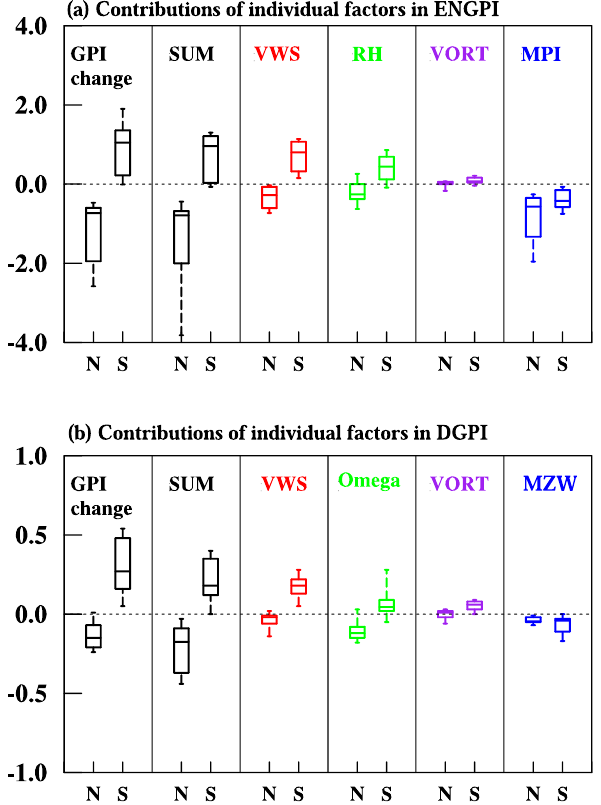
Fig. 2 Contributions of individual large-scale environmental factors to the tropical cyclone (TC) genesis frequency change. The TC genesis frequency change is measured by the anthropogenic aerosol-induced hemisphere-averaged genesis potential indices (GPIs) between the modern period (1985 – 2014) and pre-Industrial period (1850 – 1879). a Emanuel- Nolan ’ s GPI (ENGPI), b dynamic GPI (DGPI). SUM means the sum of the four individual factors ’ contribution. In ENGPI, the four factors are vertical wind shear (VWS), 600 hPa relative humidity (RH), 850 hPa absolute vorticity (VORT), and maximum potential intensity (MPI), respectively. In DGPI, the four factors include the VWS, mid-level pressure velocity (Omega), VORT, and meridional gradient of 500 hPa zonal wind (MZW). Whiskers, boxes, and the bars inside the boxes represent the 10 th – 90 th percentiles, quartile range, and median, respectively. The letters N and S represent the averages from July-October for the Northern Hemisphere and from January-April for the Southern